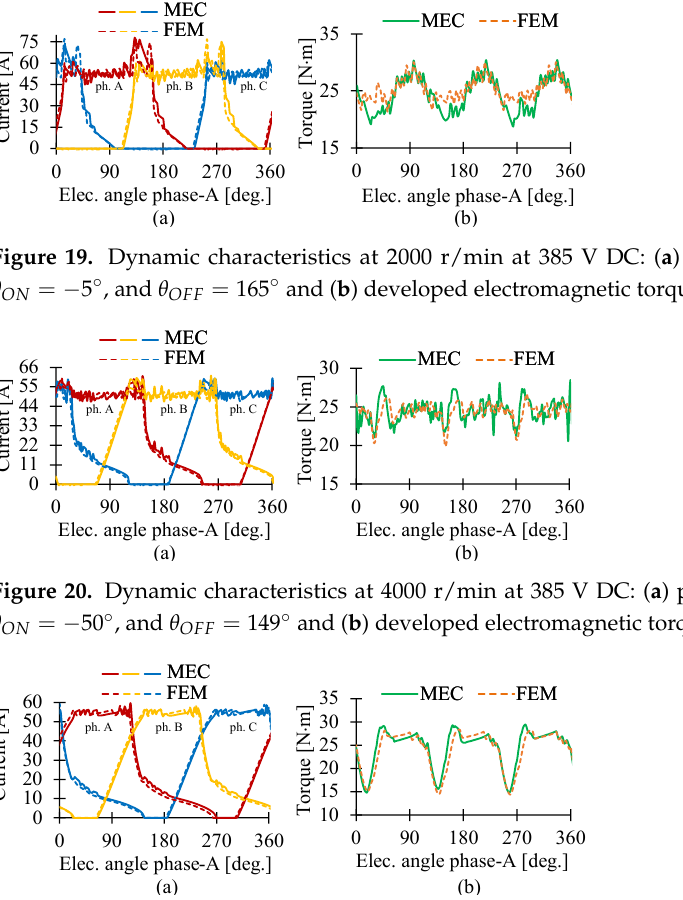
Figure 21. Dynamic characteristics at 5450 r/min at 385 V DC: ( a ) phase currents I ref = 55 A, θ ON = − 52.5 ◦ , and θ OFF = 125 ◦ and ( b ) developed electromagnetic